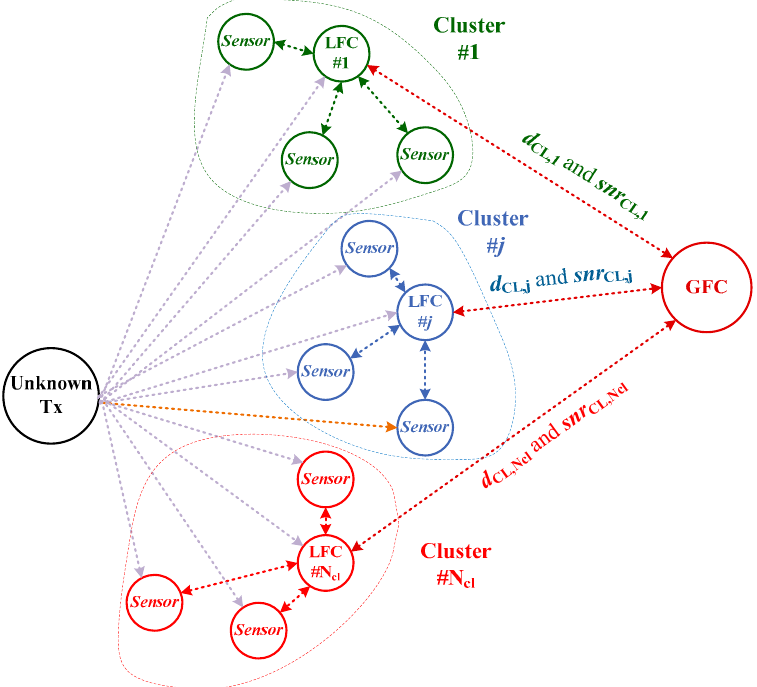
Figure 4. The general scheme of the cooperative MC with distributed two-stage fusion.